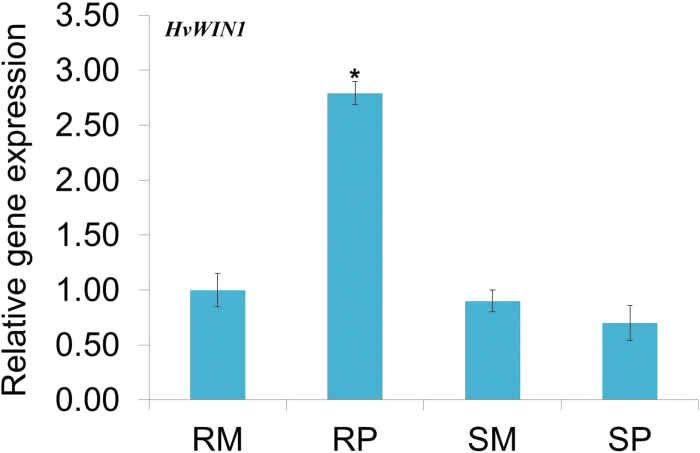
Relative transcript expression of HvWIN1 TF. The relative transcript expression was measured in the mock- and pathogen-treated resistant and susceptible genotypes compared with the mock-inoculated resistant genotype at 72 hpi. Samples: RM, resistant mock-treated; RP, resistant pathogen-treated; SM, susceptible mock-treated; SP, susceptible pathogen-treated. Significant differences in expression levels as compared in RP compared with SP using student’s t-test: *, P<0.05. A colour version of this figure is available at JXB online.